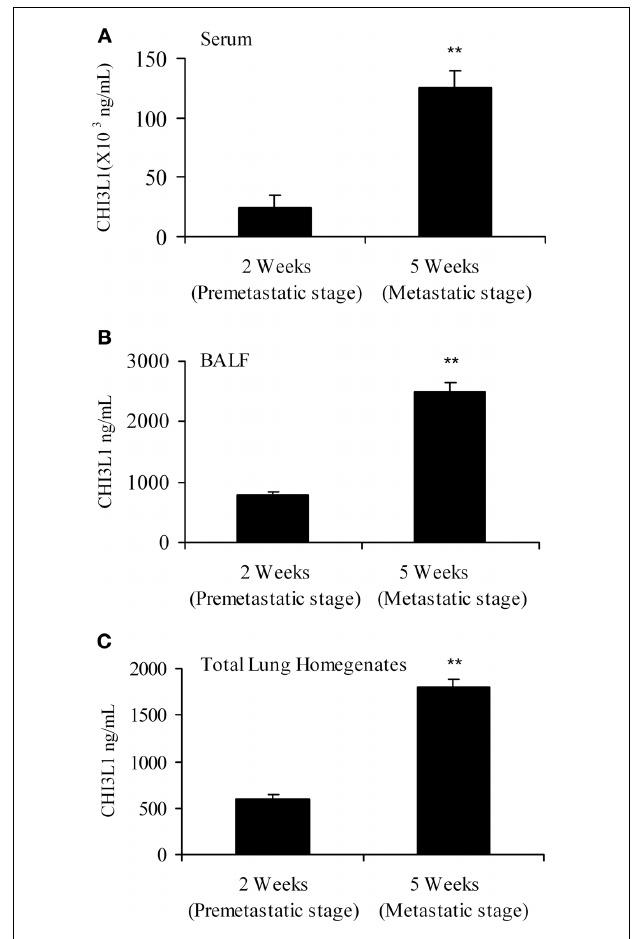
FIGURE 1 | CHI3L1 is expressed in serum and pulmonary tissue of mammary tumor-bearing mice at 2 weeks (“pre-metastatic”) and 5 weeks (metastatic) post-tumor cell implantation. (A) Serum (B) BALF and (C) Total lung homogenates from 2 week and 5 week mammary tumor bearers were analyzed for CHI3L1 expression by ELISA. N = 10 mice/group; ∗∗ p ≤ 0 .